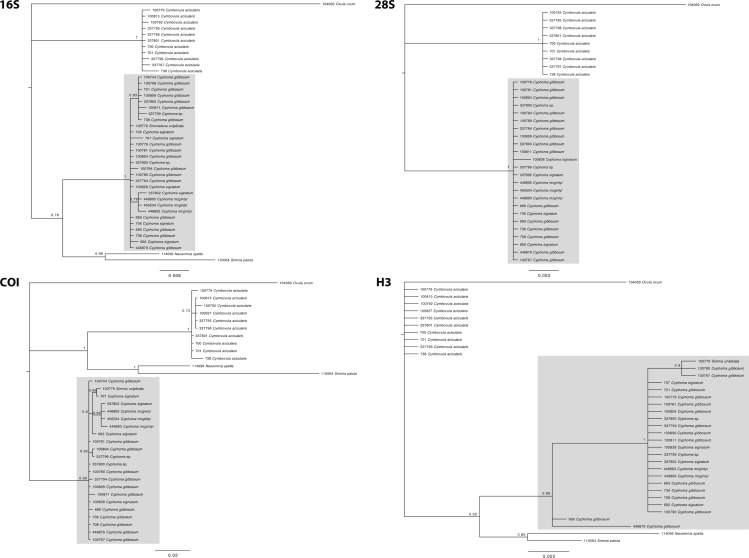
Separate gene trees.Single gene trees for the 16S, 28S, COI and H3 markers. The grey boxes highlight the clades containing the Cyphoma species.